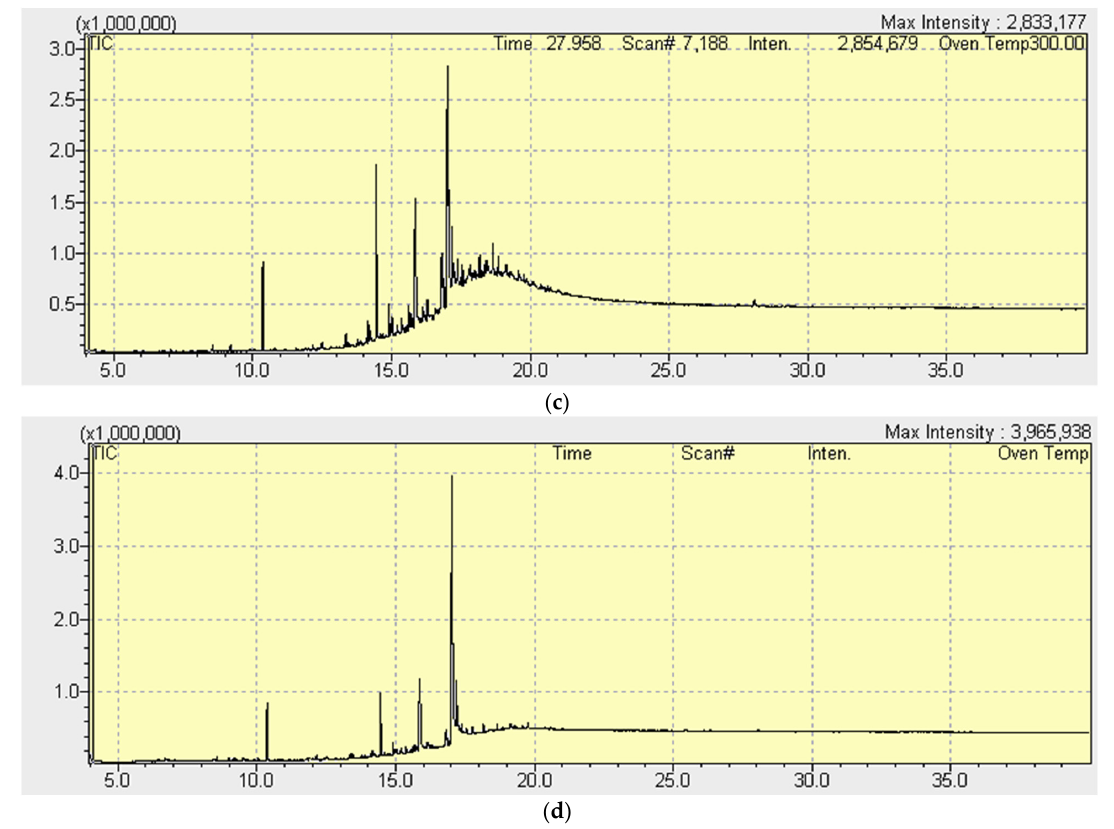
Figure 6. GC-MS chromatograms of Pleurotus ostreatus powder lipophilic extract: ( a ) FD; ( b ) HAD; ( c ) MWD; ( d ) SD. Table 1. Profile of substances of Pleurotus ostreatus powder lipophilic extract.